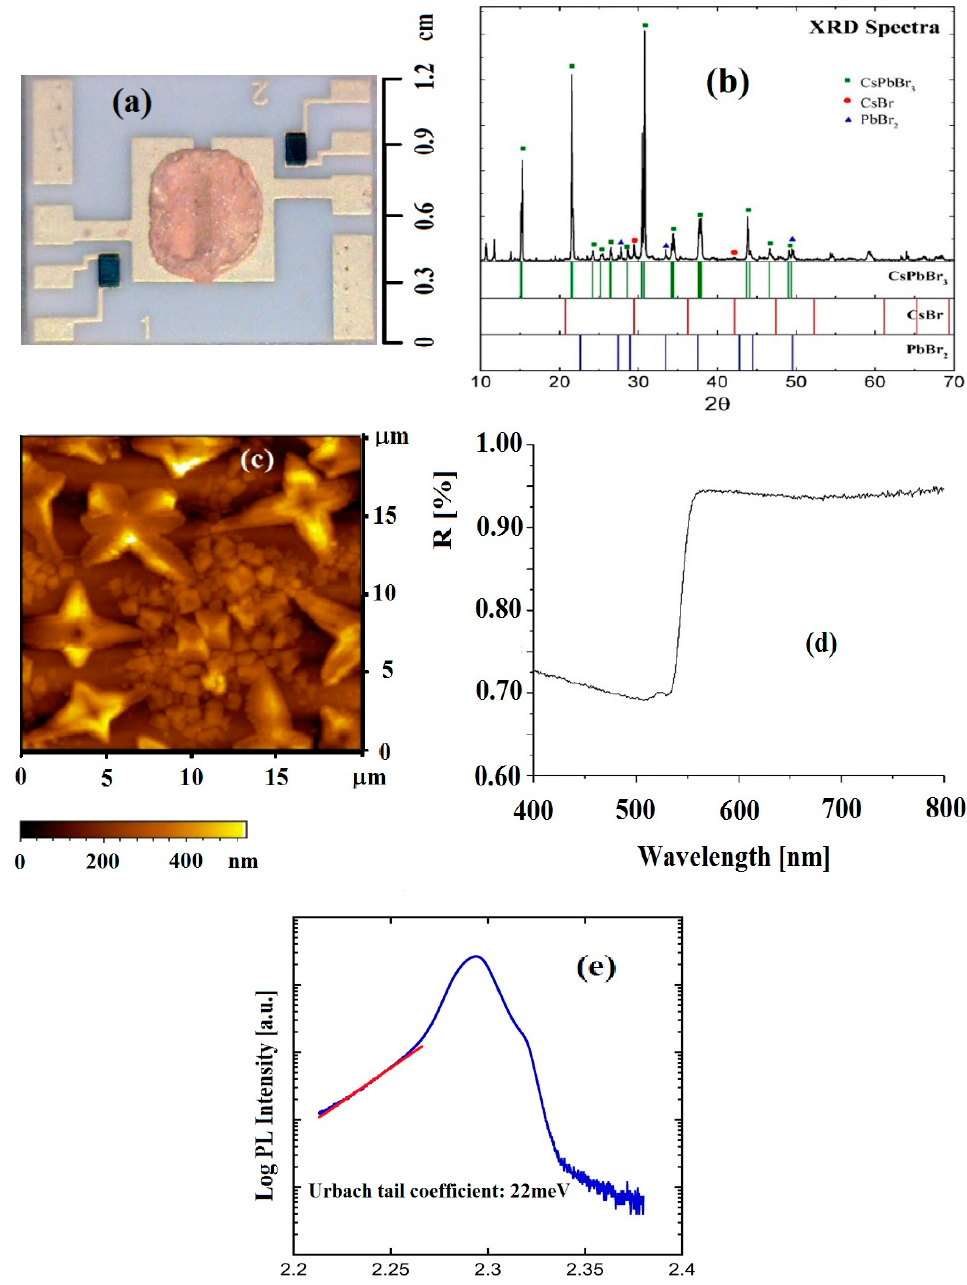
Figure 1. ( a ) Perovskite film, deposited on an alumina substrate having two parallel gold contacts, an integrated heater on the back side, and two symmetrical Pt sensors on lateral sides. ( b ) XRD spectra of the deposited material. ( c ) AFM image of the perovskite film showing its microcrystalline nature; ( d ) reflectance spectrum of the same film; ( e ) PL spectrum of a similar drop-casted sample deposited on a glass substrate, with the exponential fit showing a 22meV Urbach tail coefficient.